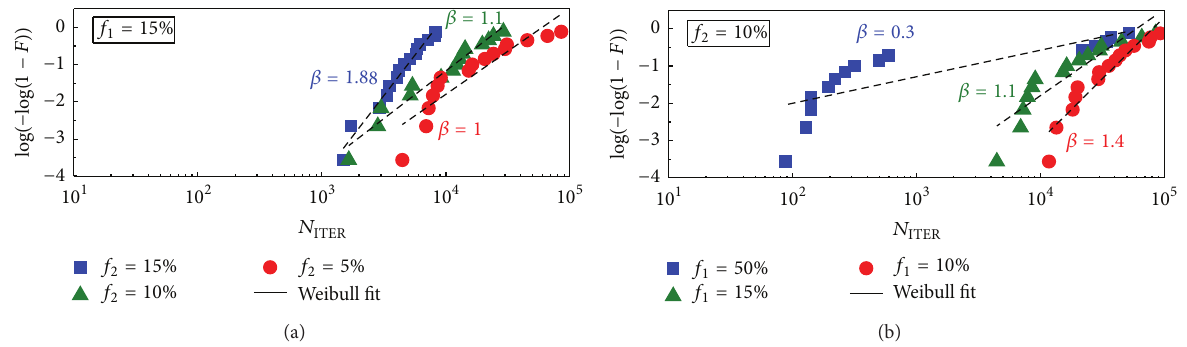
Figure 3: Weibull distributions calculated with the proposed model at 𝑉 𝑃 = 6 V, starting from native distribution of defects 𝐷 0 featuring values of 𝑓 1 and 𝑓 2 as indicated in the figure ((a) 𝑓 1 = 15 %, 𝑓 2 changing; (b) 𝑓 1 = changing, 𝑓 2 = 10